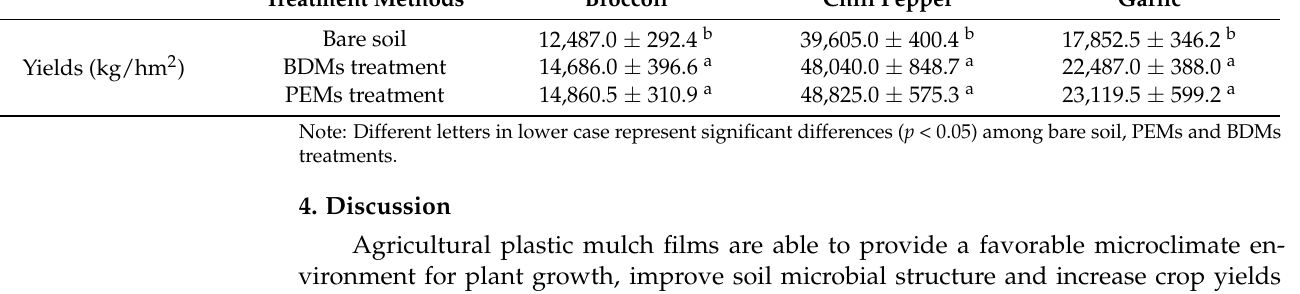
Table 3. Yields comparison of broccoli, chili pepper and garlic under different treatments (kg/hm 2 ). Treatment Treatment Methods